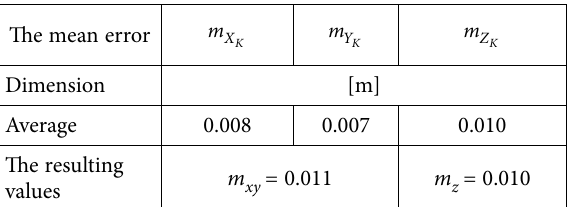
Table 4. Results of calculation errors secondary of the center coordinates wheel axis